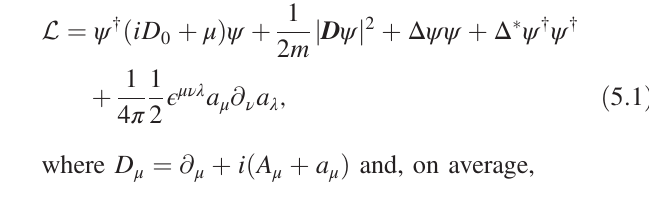
system enters the topological pairing phase ( C ¼ 1 ) whose edge statescontain a chiral Majoranamode. For Δ approaches a uniform p -wave